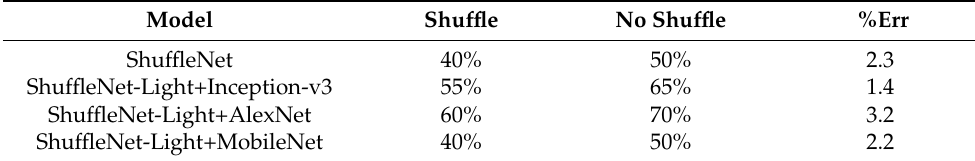
Table 11. Comparisons result of ShuffleNet models with or without channel shuffle.